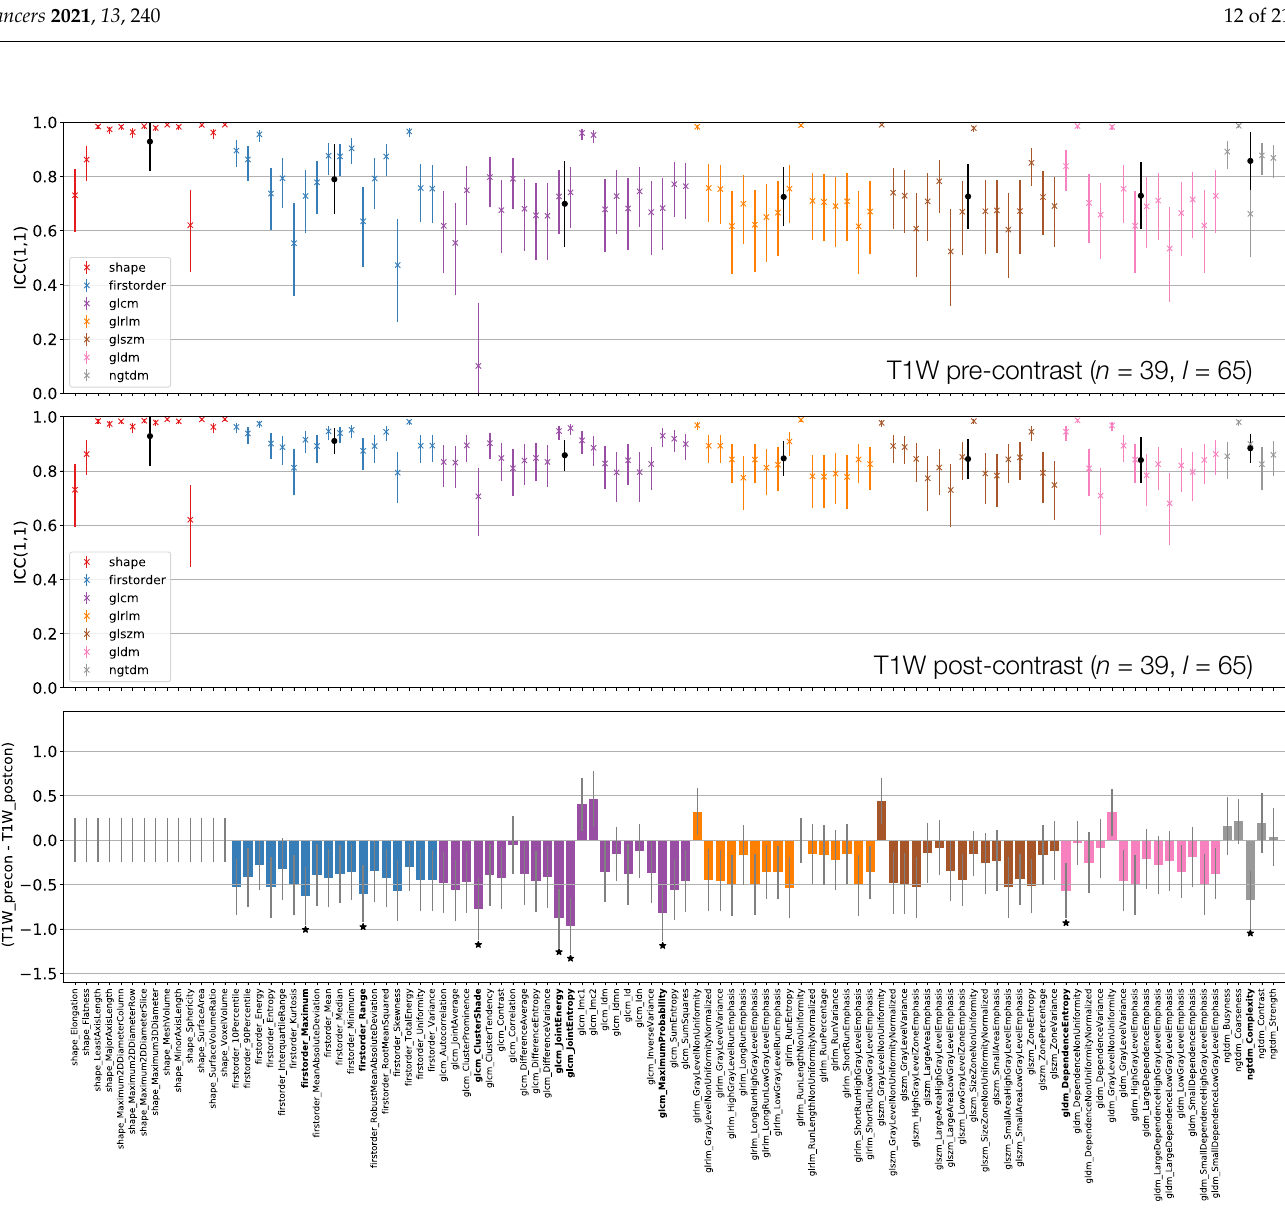
Figure 8. ICCs for Box–Cox transformed features from T 1 W pre-contrast (top) and T 1 W post-contrast (middle) images. Data points and error bars represent ICC point estimates and 95% CIs. Features are colour coded according to their class and black points correspond to mean ± ICCs over features within each class. The bottom panel represents the difference in ICCs (after applying Fisher’s Z -transformation) for T 1 W pre-contrast and T 1 W post-contrast. Black stars and bold fonts indicate features where ICCs from the two sequences are significantly different.